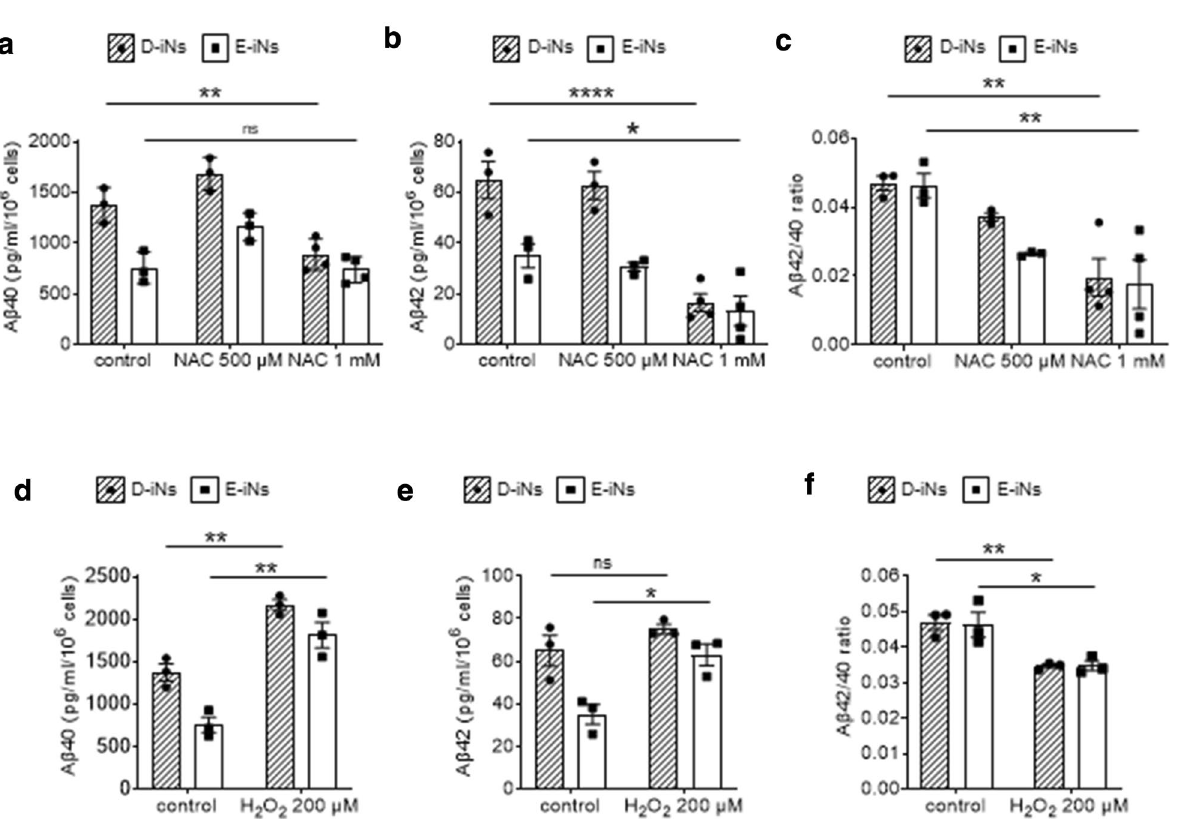
Figure 4. Effects of an oxidant or anti-oxidant on Aβ secretion from iNs. ( a–c) Amount of secreted Aβ40 (a) and Aβ42 (b) from iNs and the Aβ40 / Aβ42 ratio (c) at day 10. NAC at the indicated concentrations was added on day 8. ( d–f) Amount of secreted Aβ40 (d) and Aβ42 (e) from iNs and the Aβ40 / Aβ42 ratio (f) at day 10. H 2 O 2 (200 μM) was added on day 8. ELISA results obtained from technical duplicates and biological triplicates are shown. Data are means ± SEM; ***, p < 0.001; **, p < 0.01; *, p < 0.05; two-way ANOVA test followed by Bonferroni’s multiple comparison test (a–c) or Student’s t-test (d–f) . Control data in (a,d) , (b,e) , and (c,f) are the same as the corresponding data for days 8–10 in Fig. 3a–c,